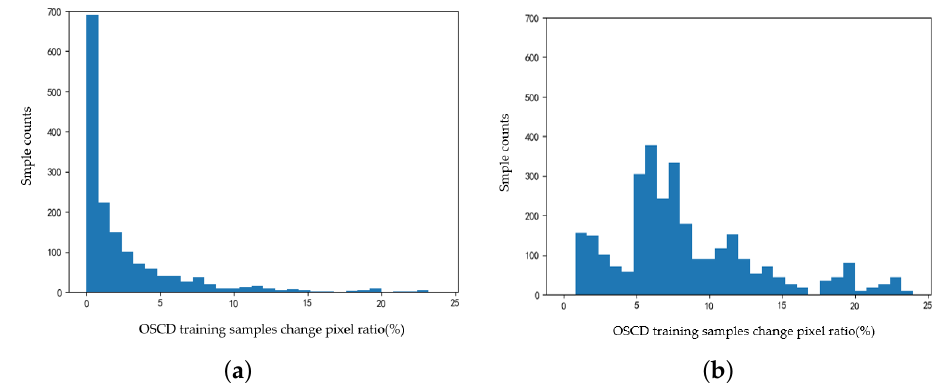
Figure 7. Distribution of change pixels in OSCD. ( a ) Before sample equalization. ( b ) After sam- ple